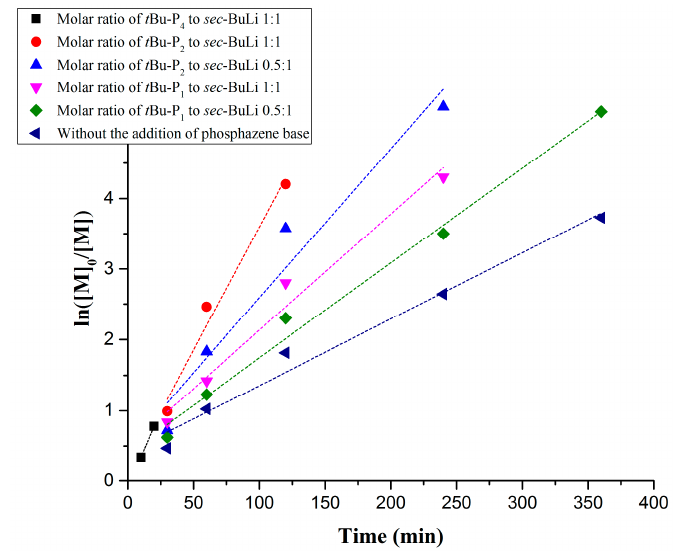
Figure 1. Kinetic plots of anionic polymerization of styrene in the presence of t -BuP 4 , t -BuP 2 , t -BuP 1 and in the absence of phosphazene base.